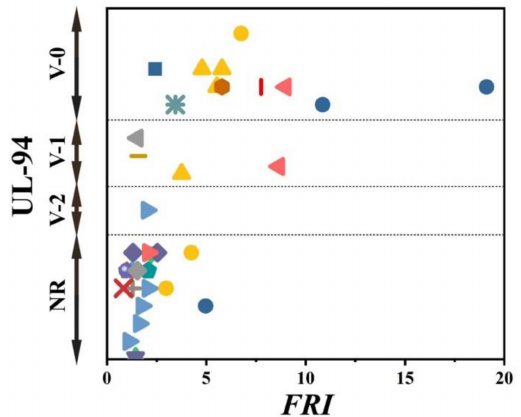
Figure 5. FRI values versus UL-94 test results. Symbols are indicative of di ff erent types of nitrogen flame retardant (FR) used. The vertical intervals in each category, i.e., V-0, V-1, V-2, and NR, are schematically representative of the amount of additive used. For example, two data distinguished by di ff erent symbols having the same or very close FRI values (horizontal quantity) in a given category (e.g., V-1), may have di ff erent vertical quantities; e.g., both reveal V-1 behavior in UL-94 test, but the upper contains more FR in